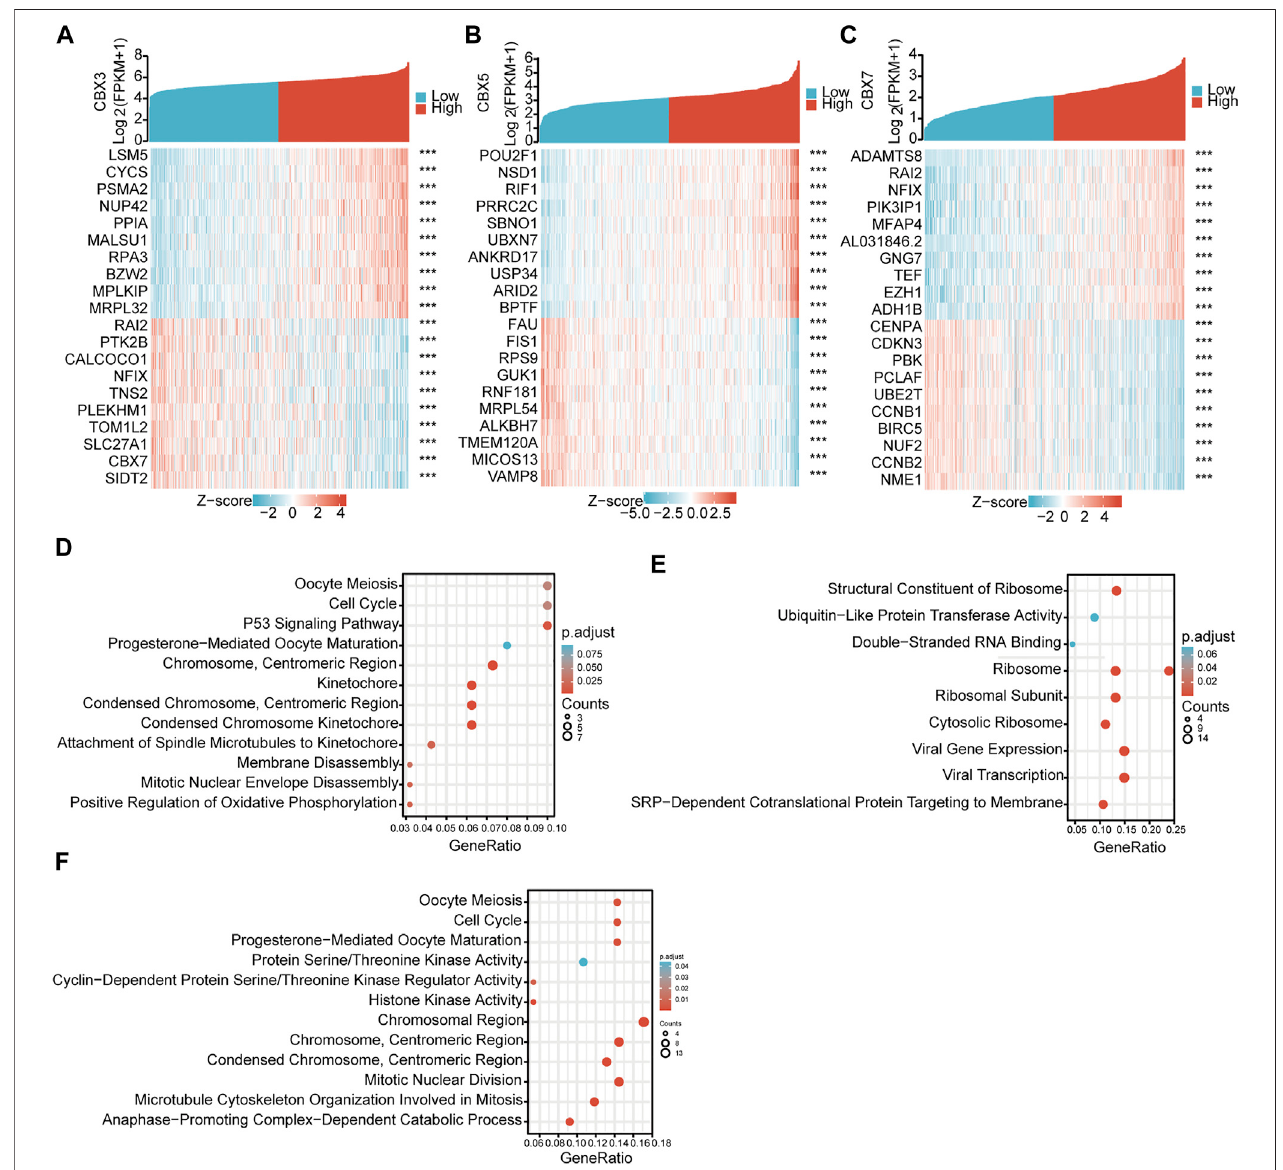
FIGURE 5 | GO and Pathway enrichments of CBX3/5/7 co-expressed genes. (A) Co-expressed genes of CBX3, (B) CBX5, and (C) CBX7. (D – F) Bioinformatics analysis of CBX3, CBX5, and CBX7 co-expressed genes in LUAD. *** p < 0.001.